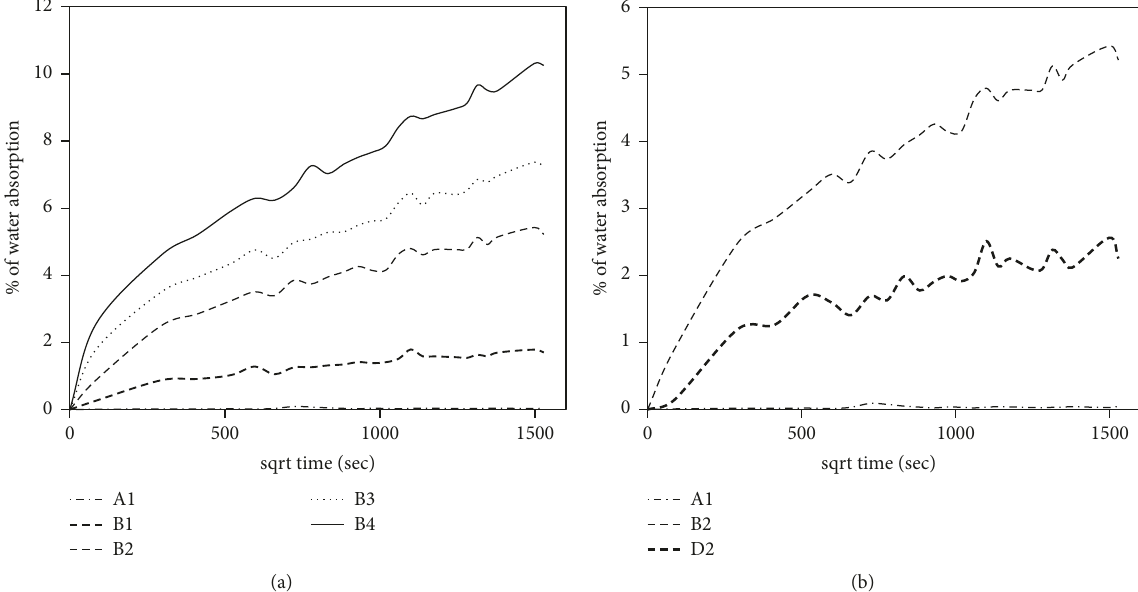
Figure 12: Percent mass gain due to the absorption of water for (a) composites types A and B; (b) composites types A1, B2, and